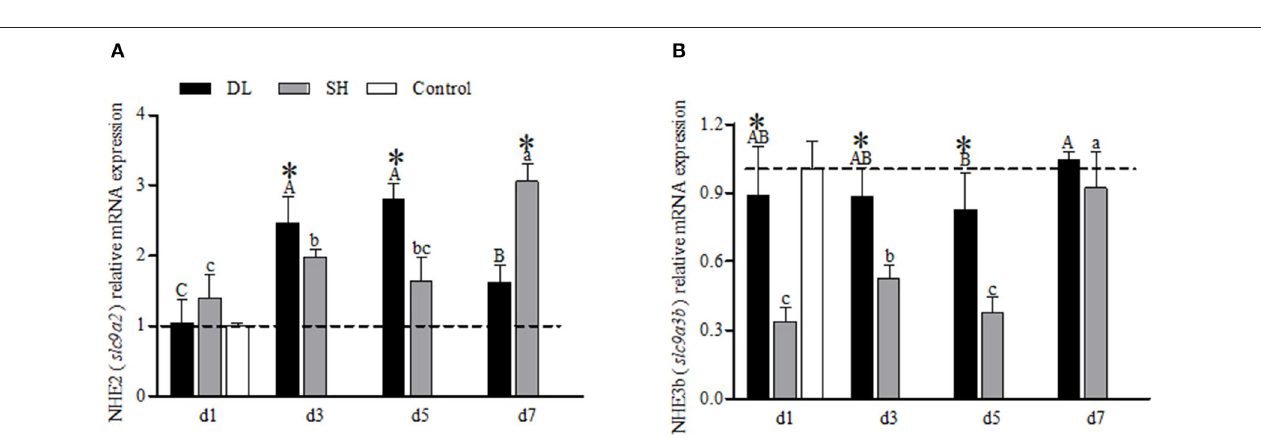
FIGURE 4 | Gill NHE2 ( slc9a2 ) and NHE3b ( slc9a3b ) mRNA levels ( n = 3) for DL (the alkali form introduced from Lake Dali Nor) and SH (the freshwater form introduced from Songhua River) fish. Different uppercase letters indicate significant differences within DL, and different lowercase letters indicate significant differences within SH. The asterisk (*) denotes a significant difference found in the NHE2 or NHE3b mRNA levels between DL and SH exposed to bicarbonate